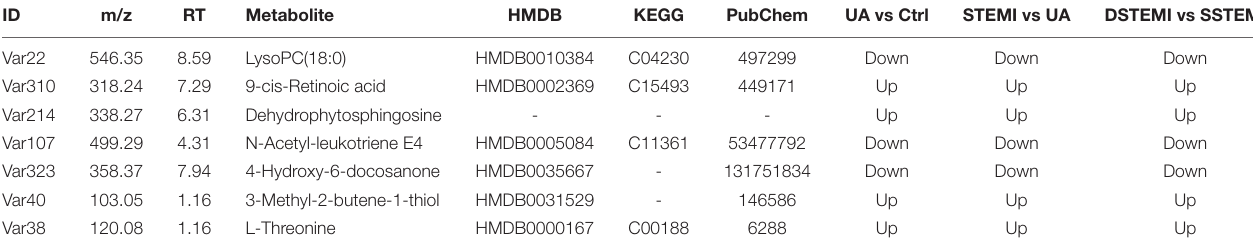
TABLE 2 | Identification of seven